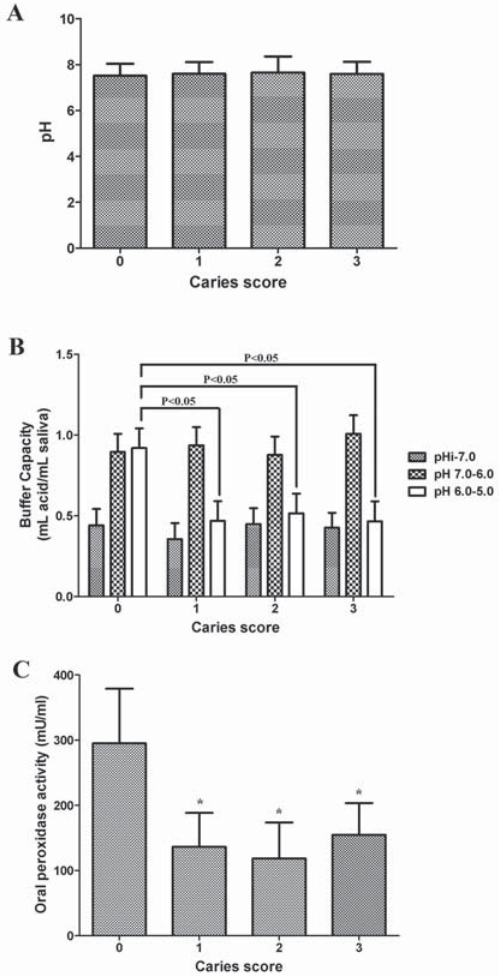
FIGURE 1. pH, Buffer capacity and oral peroxidase activ- ity in saliva. Cleared unfractionated saliva was used for pH determination. The buffer capacity was determined by titration using 1 mL of saliva, with 0.01 M HCl and after each addition of acid the change in pH was monitored up to pH 5.0. The buffer capacity was analyzed by ranges of pH. The volume of acid added to the saliva was calculated for each interval considered: initial pH-7.0, pH 7.0-6.0, and pH 6.0-5.0. No dif- ference in the saliva pH between the groups was noted (A).